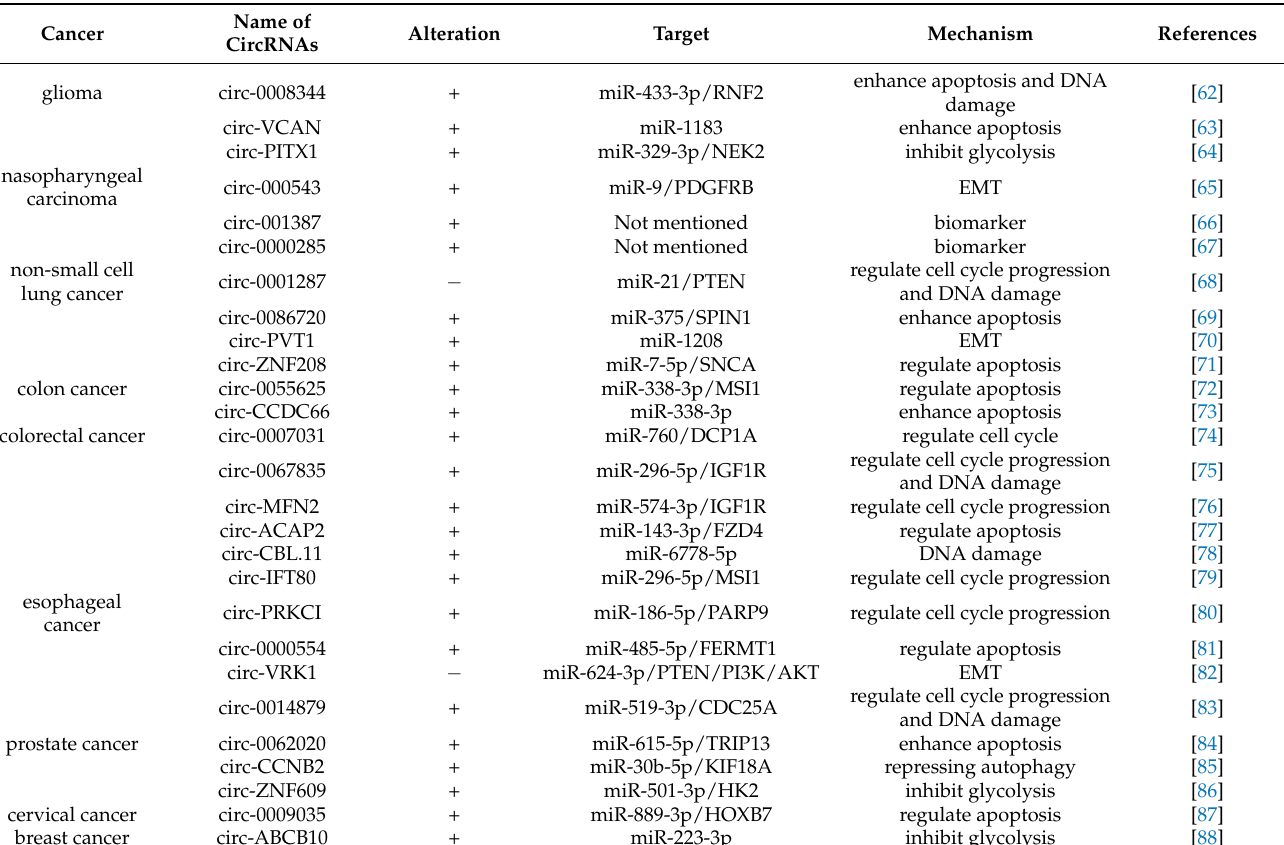
Table 1. Alterations of circRNAs in radiotherapy